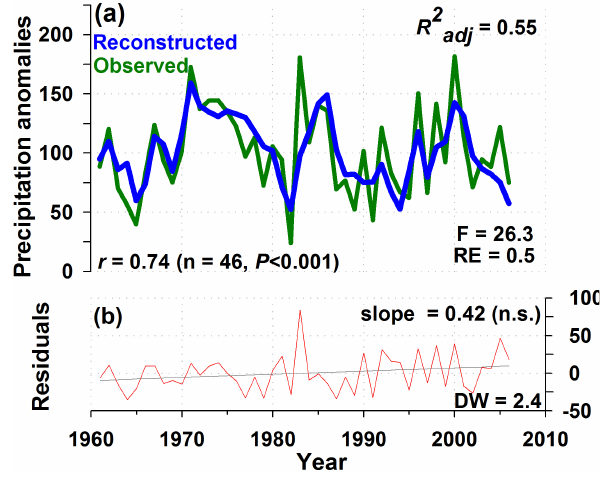
Fig. 2. Observed and tree-ring predicted annual precipitation (November–October) variations across the South American Alti- plano (annual precipitation expressed as percentages (%) of the 1982–2000 instrumental precipitation mean). Calibration and veri- ) over the calibration pe- fication statistics: explained variance ( R 2 adj riod, the Pearson correlation coefficient ( r) between observed and reconstructed values, F-value of the regression, and the reduction of error (RE) (a) . Regression residuals (red line) with trend slope (black line). The Durbin-Watson (D-W) statistic and the slope value are indicated (b)